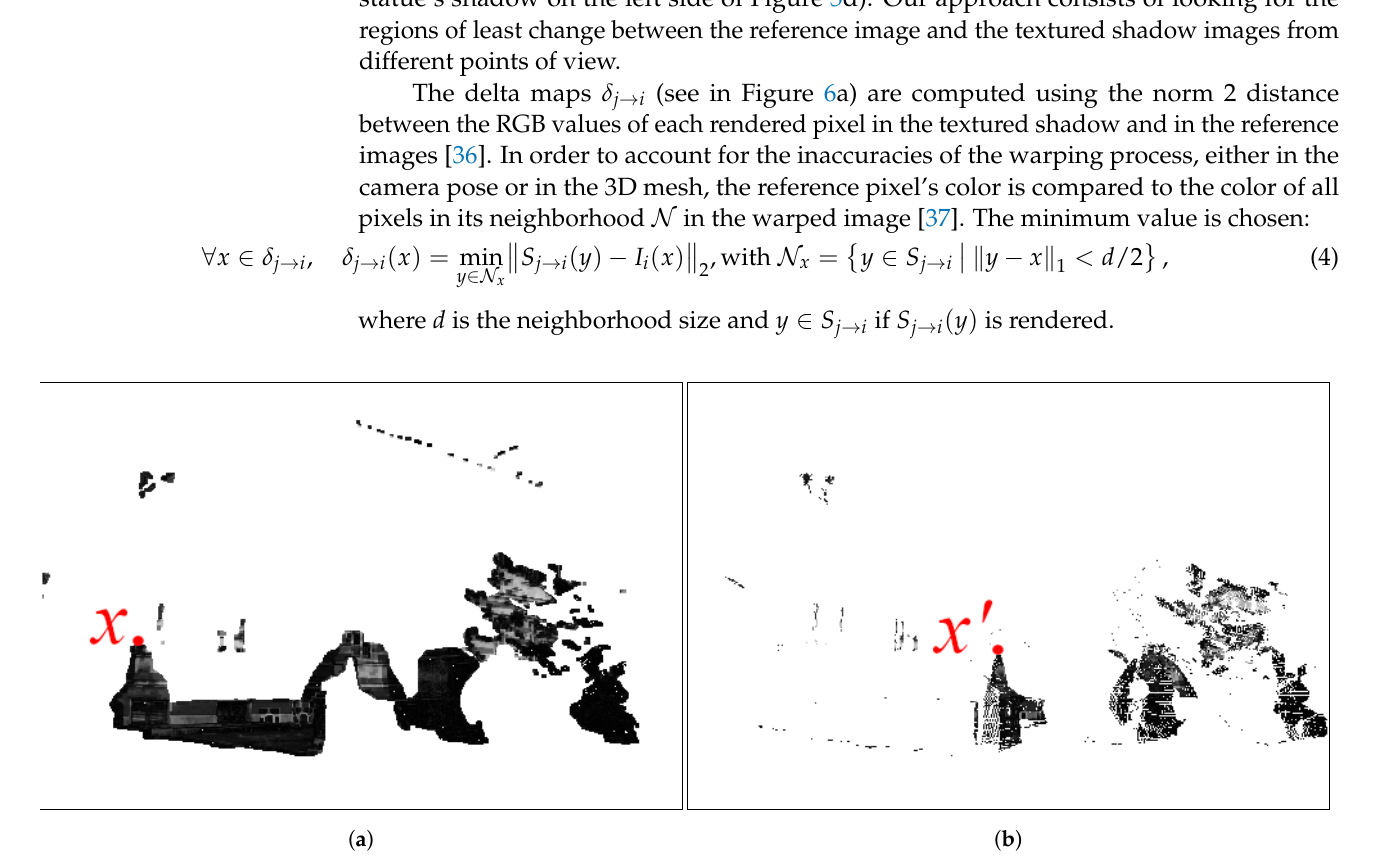
Figure 6. Once photo-consistency is evaluated in the occluded parts of the image, the potential changes are located in the foreground. ( a ) Delta map δ j → i . ( b ) Projected map ∆ j → i